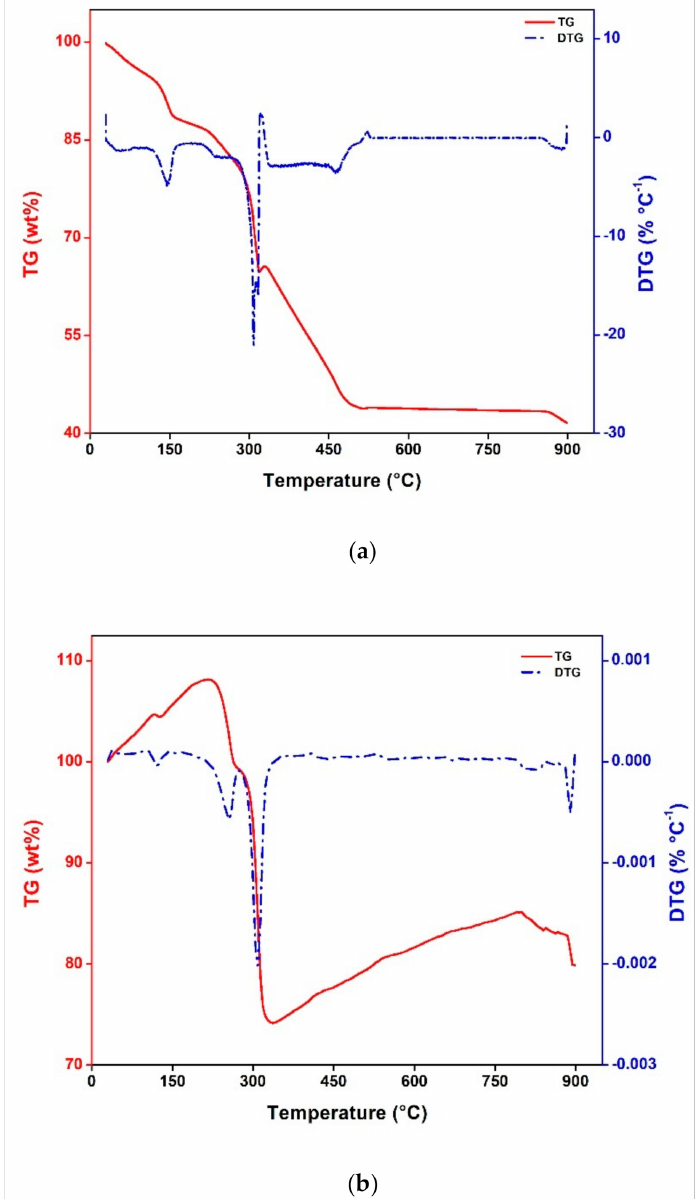
Figure 2. TGA of CN-R in ( a ) N 2 and ( b ) air